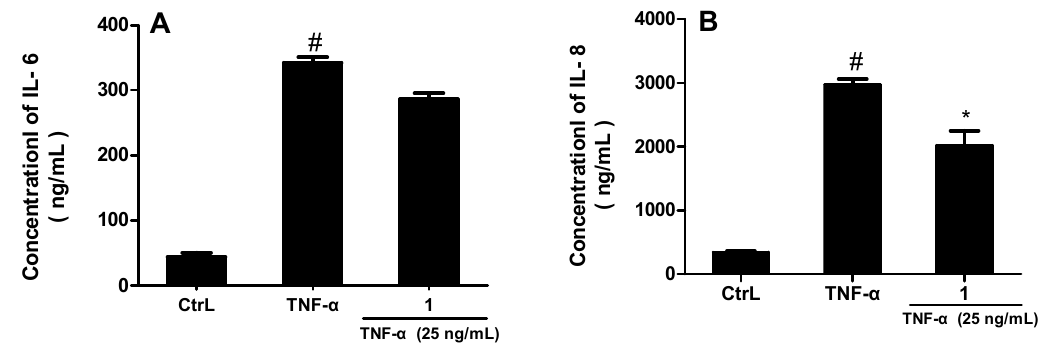
Figure 4. Compound 1 inhibited TNF- α -induced IL-6 and IL-8 production (* p < 0.05; # p < 0.01 vs. control).